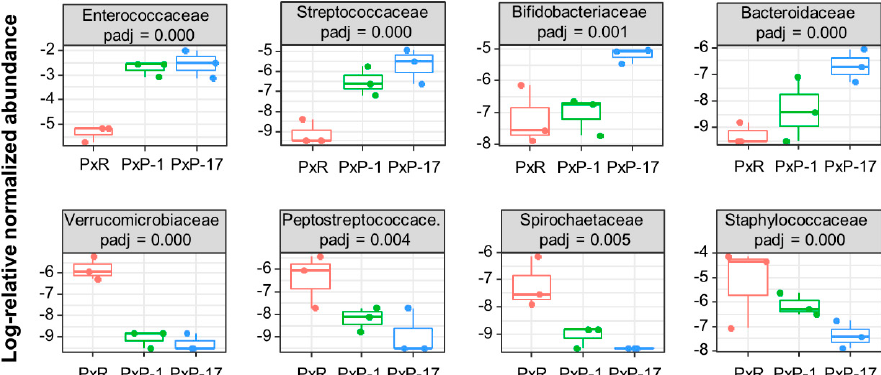
Figure 3. Trends of di ff erential family abundance of the gut microbiota after host shift. Boxes show the interquartile ranges (25–75%), and the bands inside indicate median. Whiskers show the 1.5 × upper or lower interquartile connected with a solid line. Pearson correlation test was performed. Padj corresponds to the p -value adjusted for multiple testing using the Benjamini–Hochberg method with a significance level of <0.01. PxR, P. xylostella feeding on radish; PxP-1 and PxP-17, the 1st and 17th generation of P. xylostella , respectively, feeding on peas after the host shift from radish.